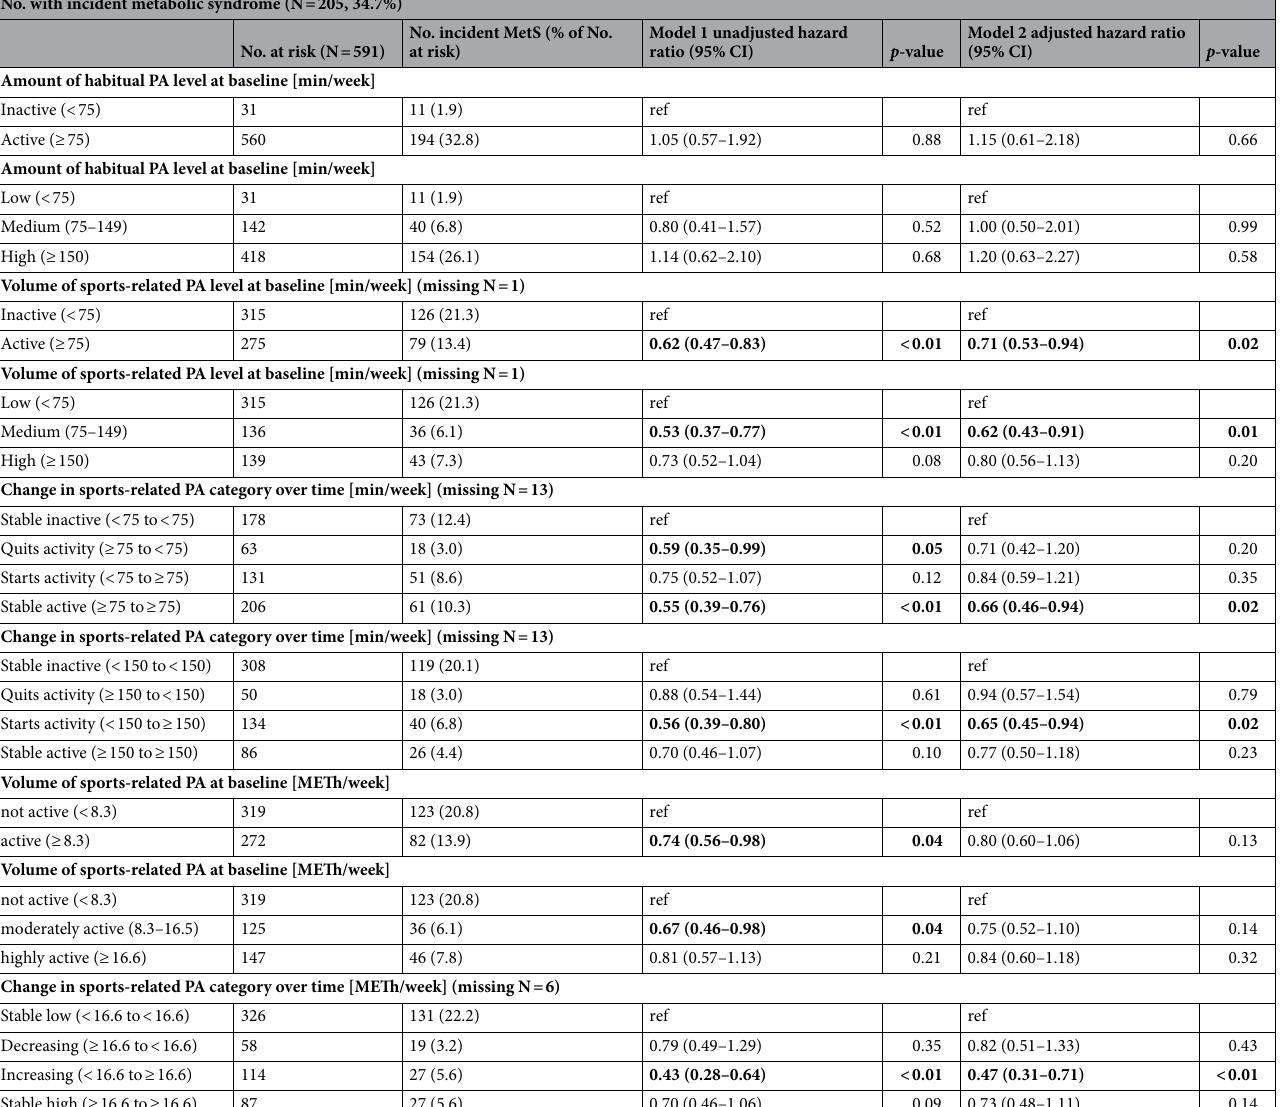
Table 3. Association between PA variables and the risk of incident MetS. CI confidence interval, METh metabolic equivalent hours, min minutes, N number of participants, No Number, PA physical activity, ref reference group, SES socio-economic status. Model 1: unadjusted; Model 2: adjusted for age, sex und SES. Significant values are in